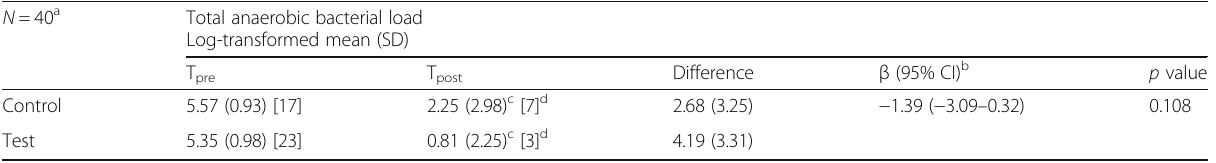
Table 2 Log-transformed mean bacterial anaerobic counts (SD) of culture-positive implants for the control and test group before (T pre ) and after (T post ) debridement and decontamination of the implant surface (intra-operative microbrush samples) N = 40 a